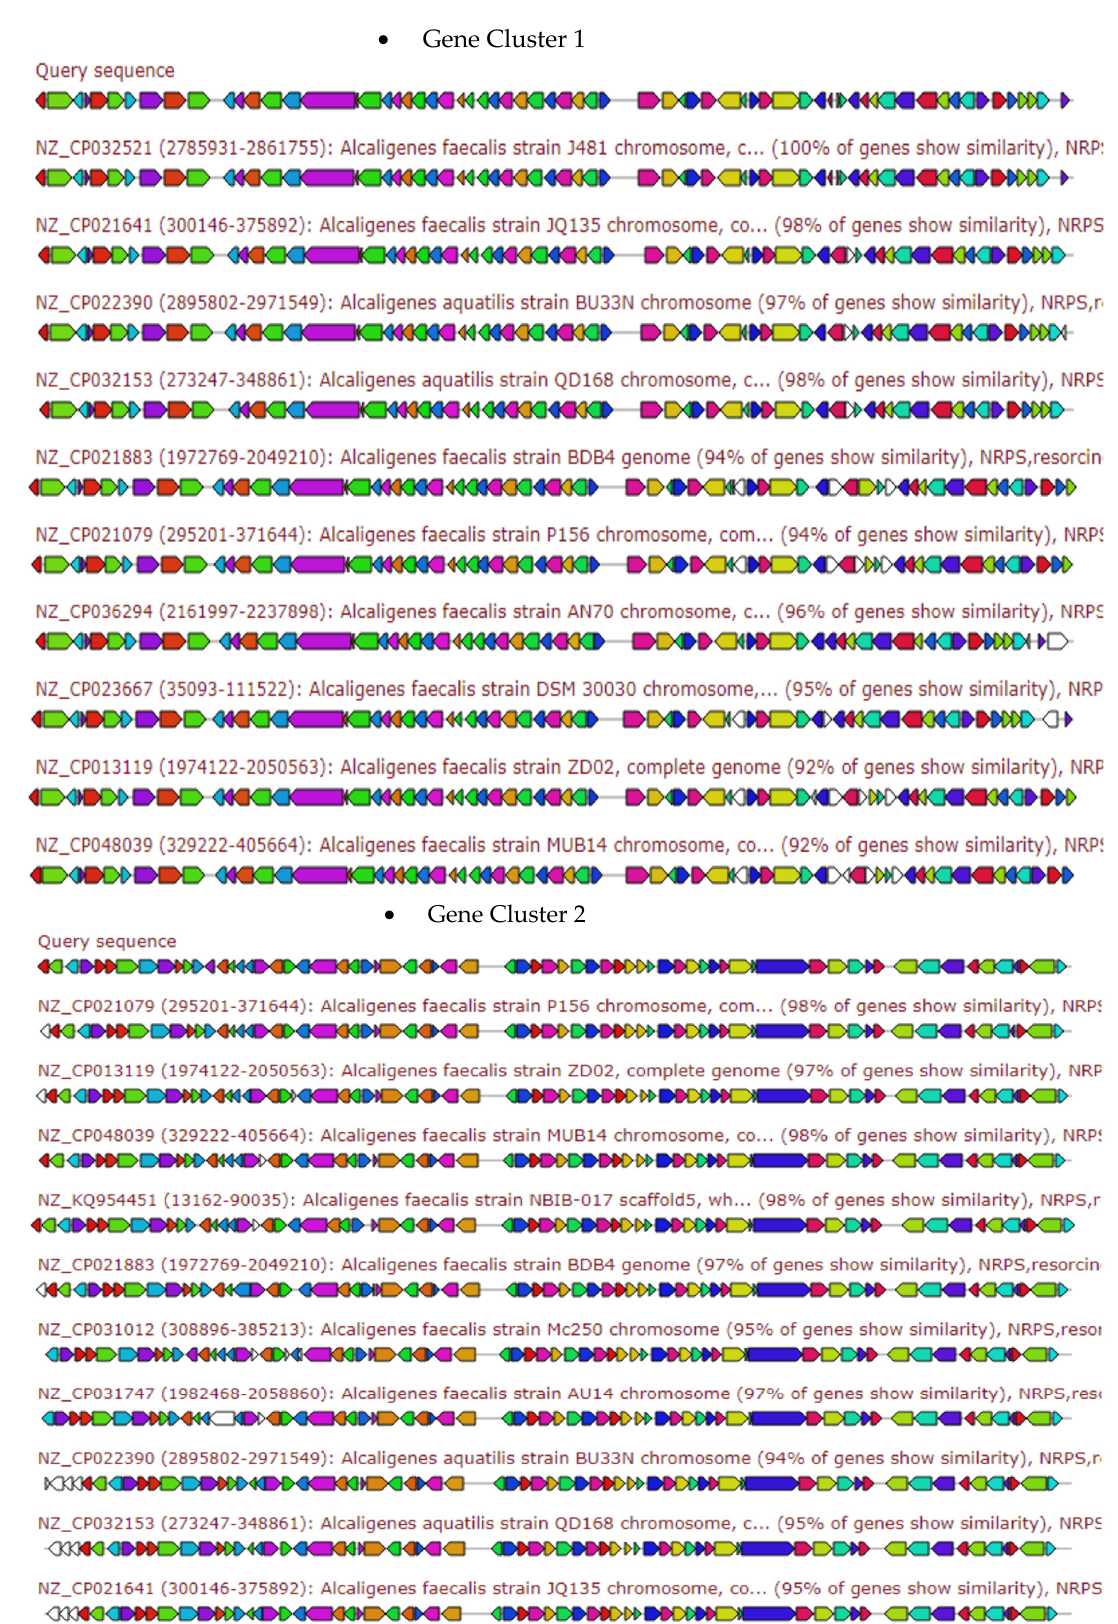
Figure 5. Gene arrangement of resorcinol and multi-modular non-ribosomal peptide synthase (NRPS) gene clusters of various Alcaligenes sp. homologous to query sequence of A. faecalis isolate MZ921504. Putative biosynthetic genes presented in red, additional biosynthetic genes in orange, transport-related genes in blue, regulation-related genes in green color, resistance genes in pink, TTA codon in dark